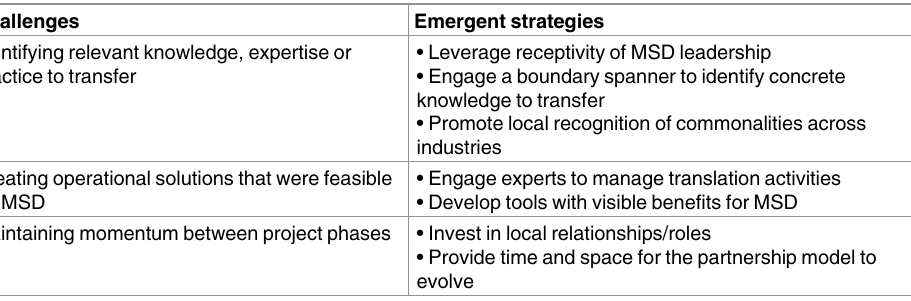
Table 3. Challenges and emergent